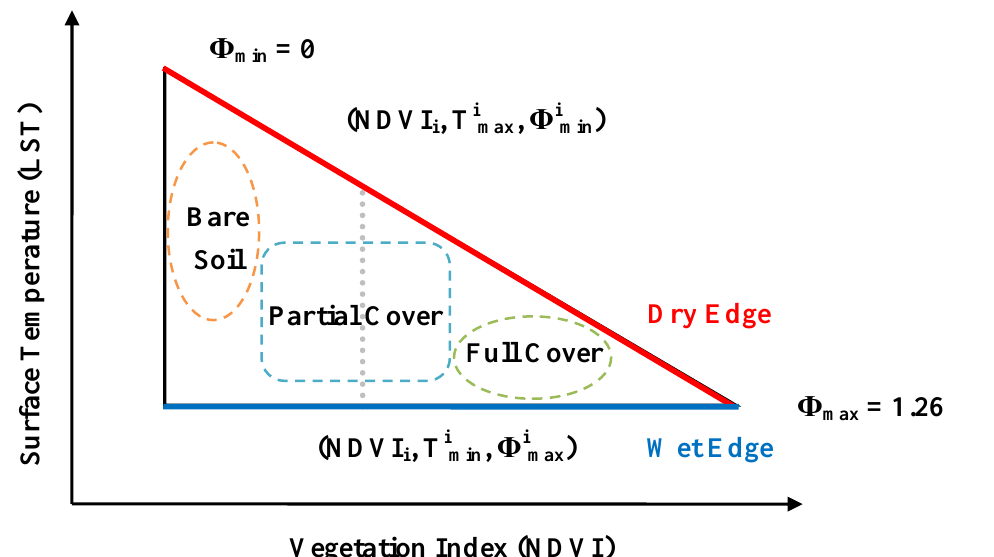
Figure 1. Conceptual diagram of the LST/NDVI scatter